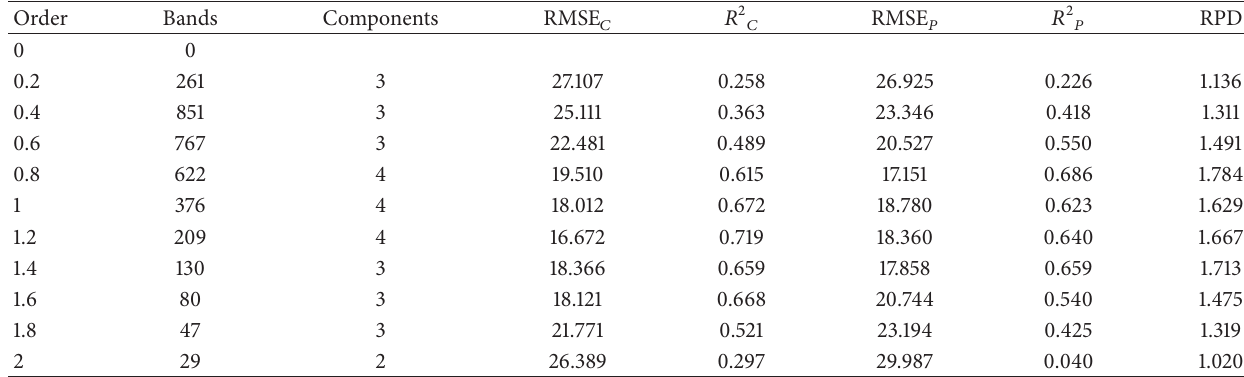
Table 4: The results of the PLSR models based on 1/𝑅 .